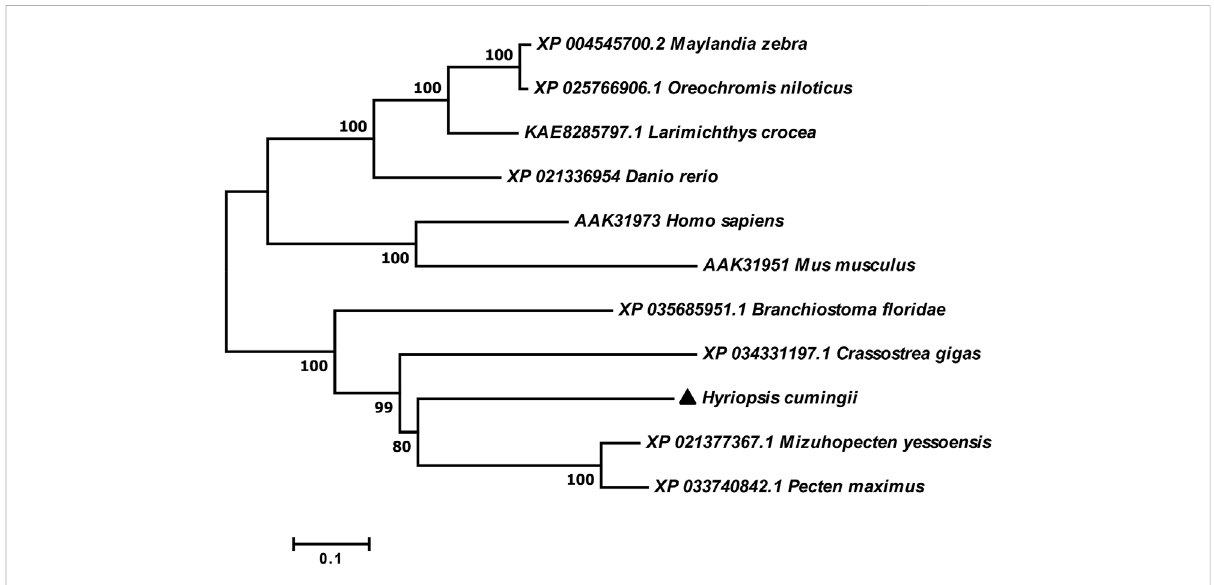
FIGURE 3 Phylogenetic tree of TEX11 in different